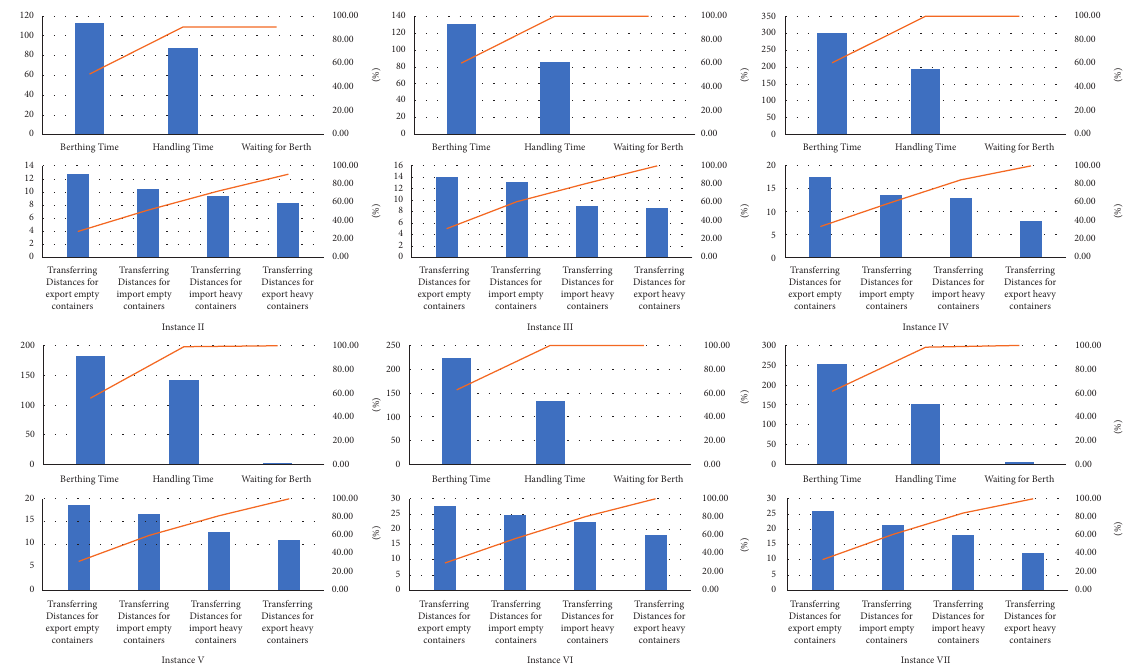
Figure 8: The Pareto analysis of each